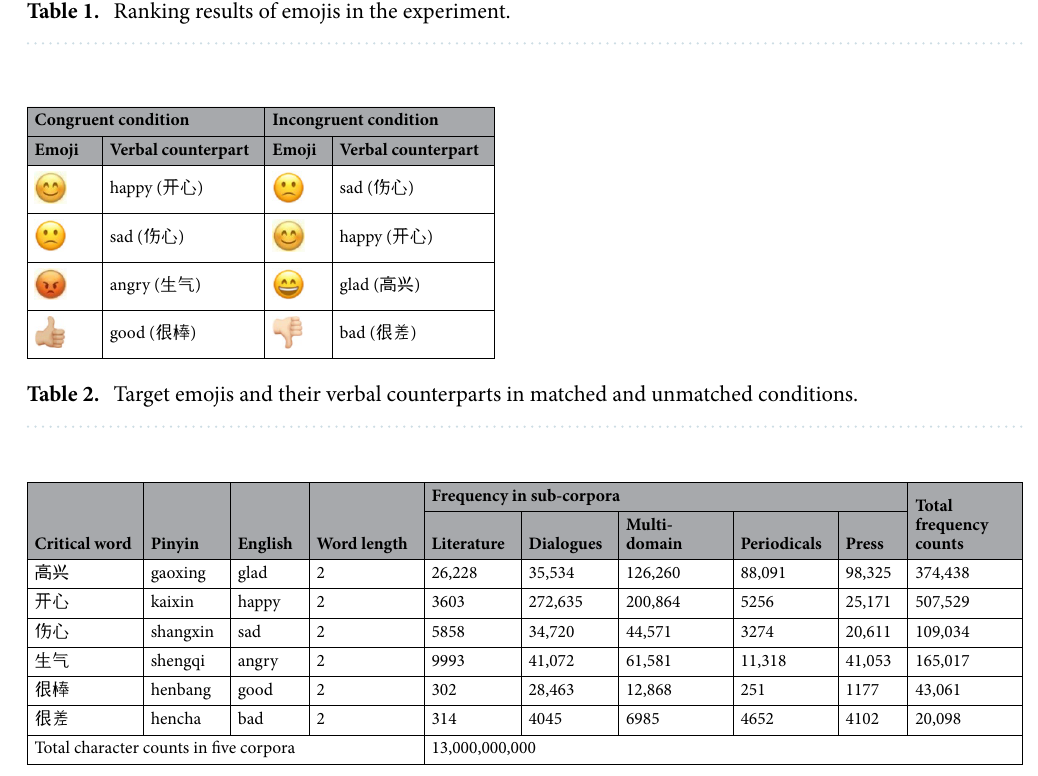
Table 3. Frequency counts of critical